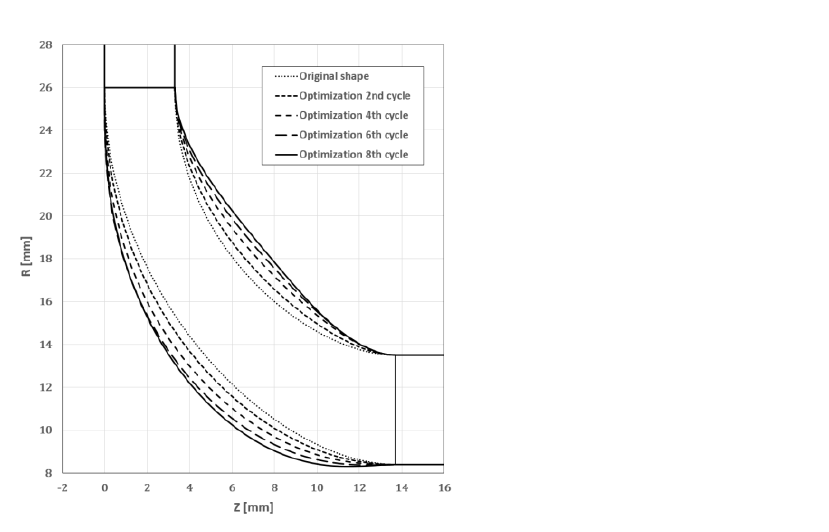
Figure 12. Comparison of blade 𝛽 angle distributions obtained by shape optimization.